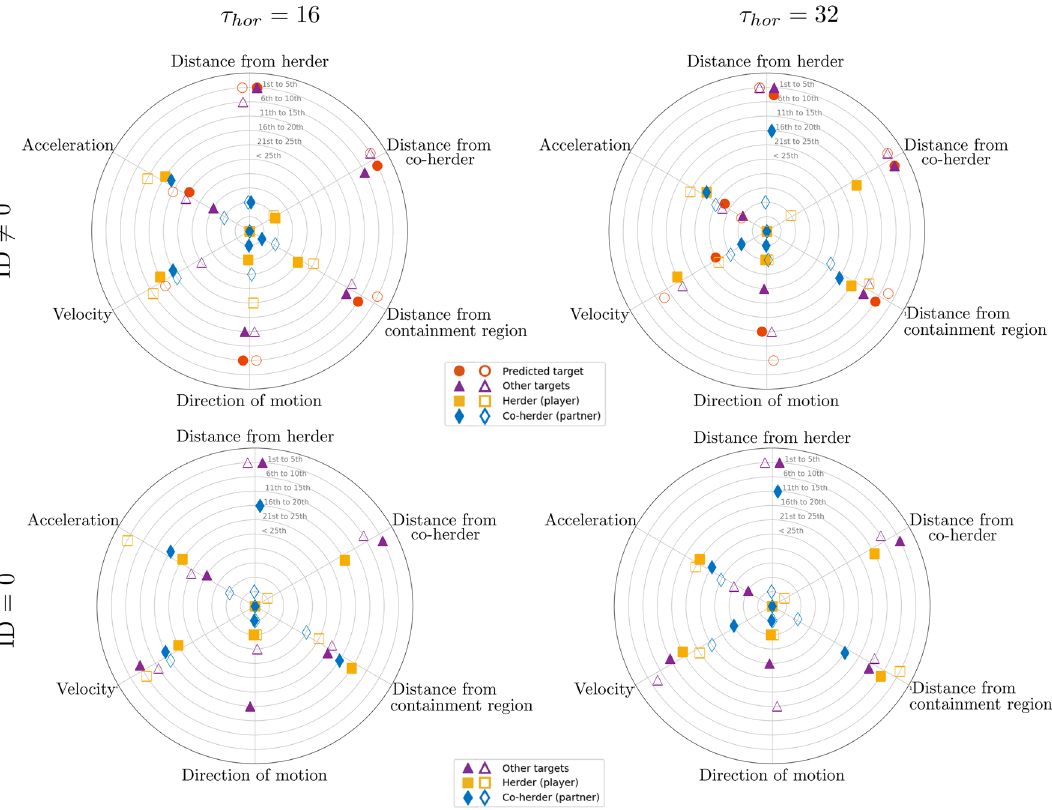
Figure 6. SHAP results for target prediction ( top row ) ID 6 = 0 (i.e., ID = 1 to 4) and ( bottom row ) ID = 0, as a function of prediction horizon and expertise (novice = empty shapes, expert = filled shapes). Feature type is listed on the vertices. The radial axis represents the average rank position, such that “1st to 5th” represents a feature that was always or nearly always ranked as a top-five